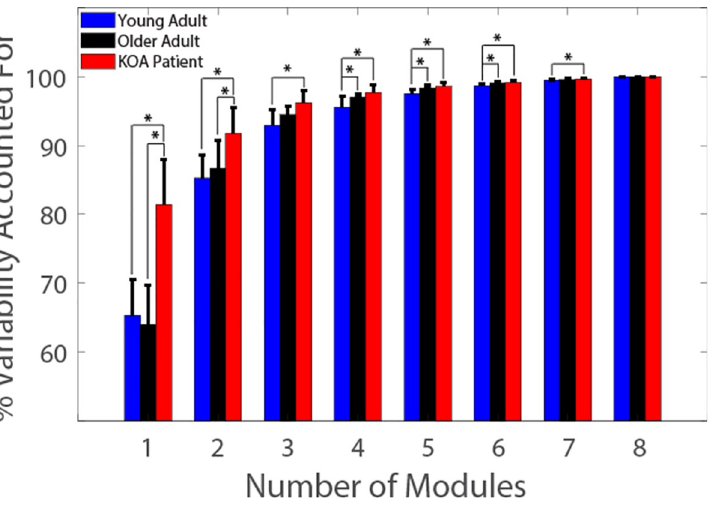
Fig 2. Total variability accounted for by n modules. � indicate significant pairwise differences between populations.